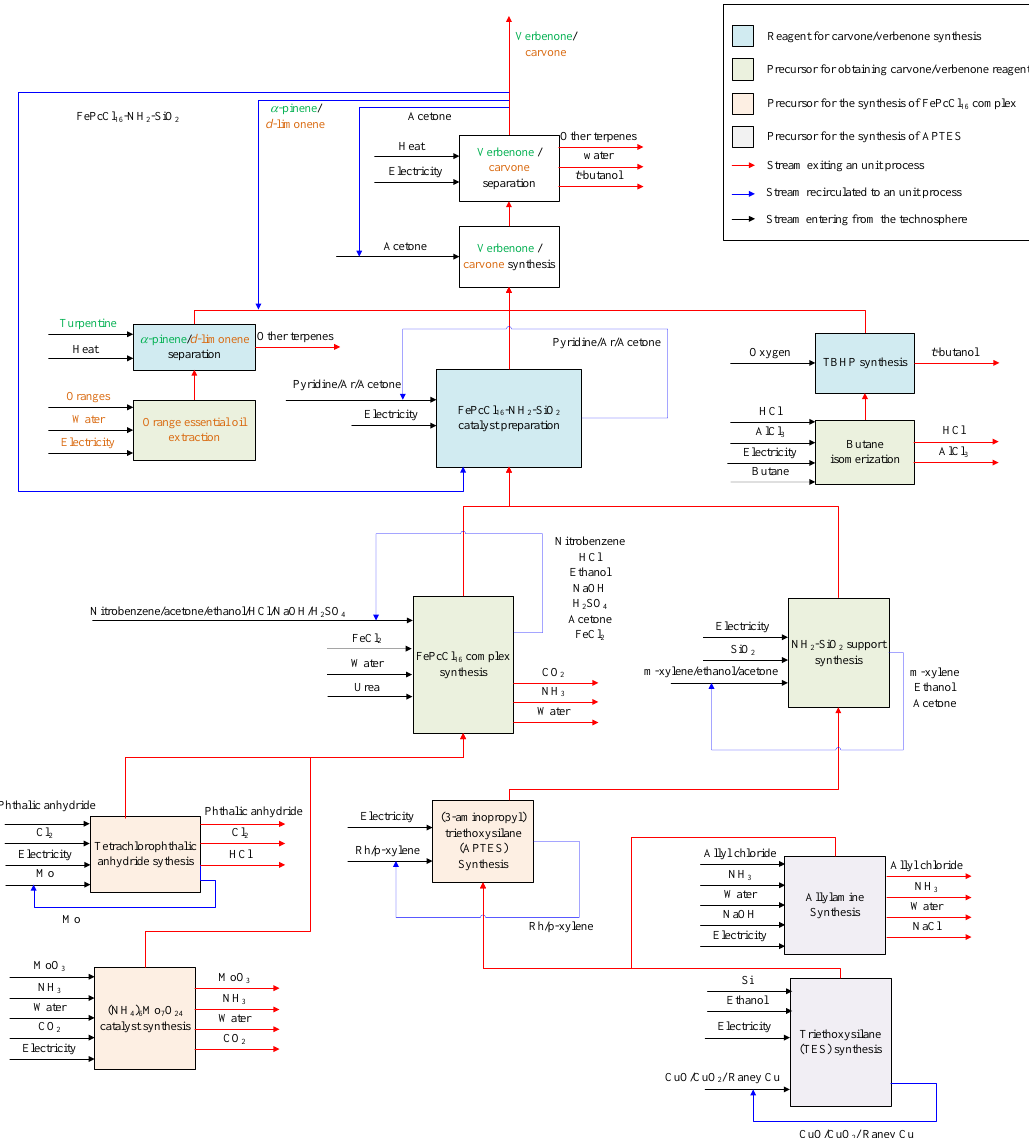
Figure 4. Process block diagram of the LCI for the batch production of verbenone and carvone from turpentine and orange oils oxidation with TBHP and FePcCl 16 -NH 2 -SiO 2 (See detailed description in Supplementary Materials).